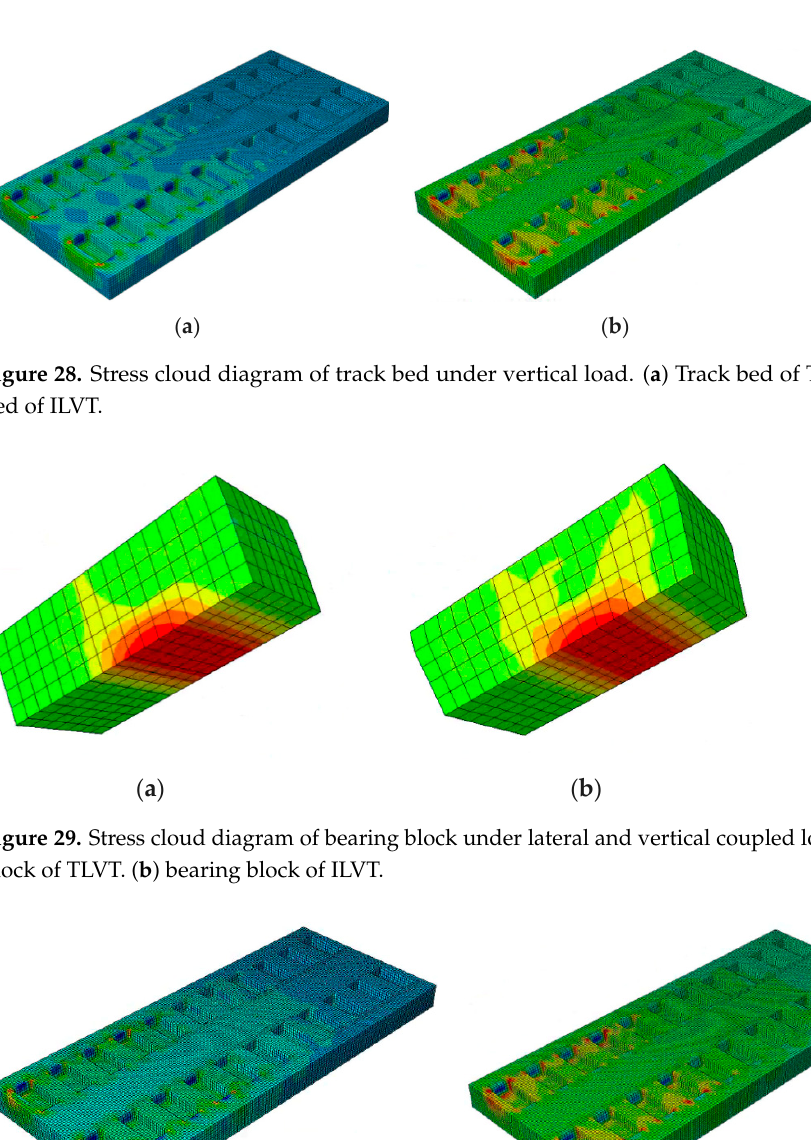
Figure 27. Stress cloud diagram of bearing block under vertical load. ( a ) bearing block of TLV. ( b ) bearing block of ILVT.